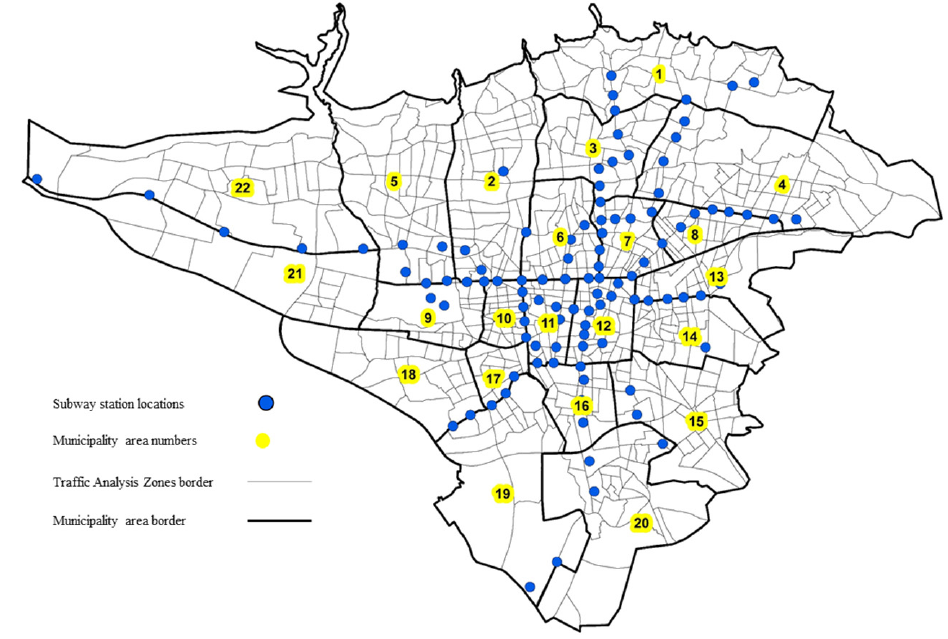
Figure 4. Location of subway stations.